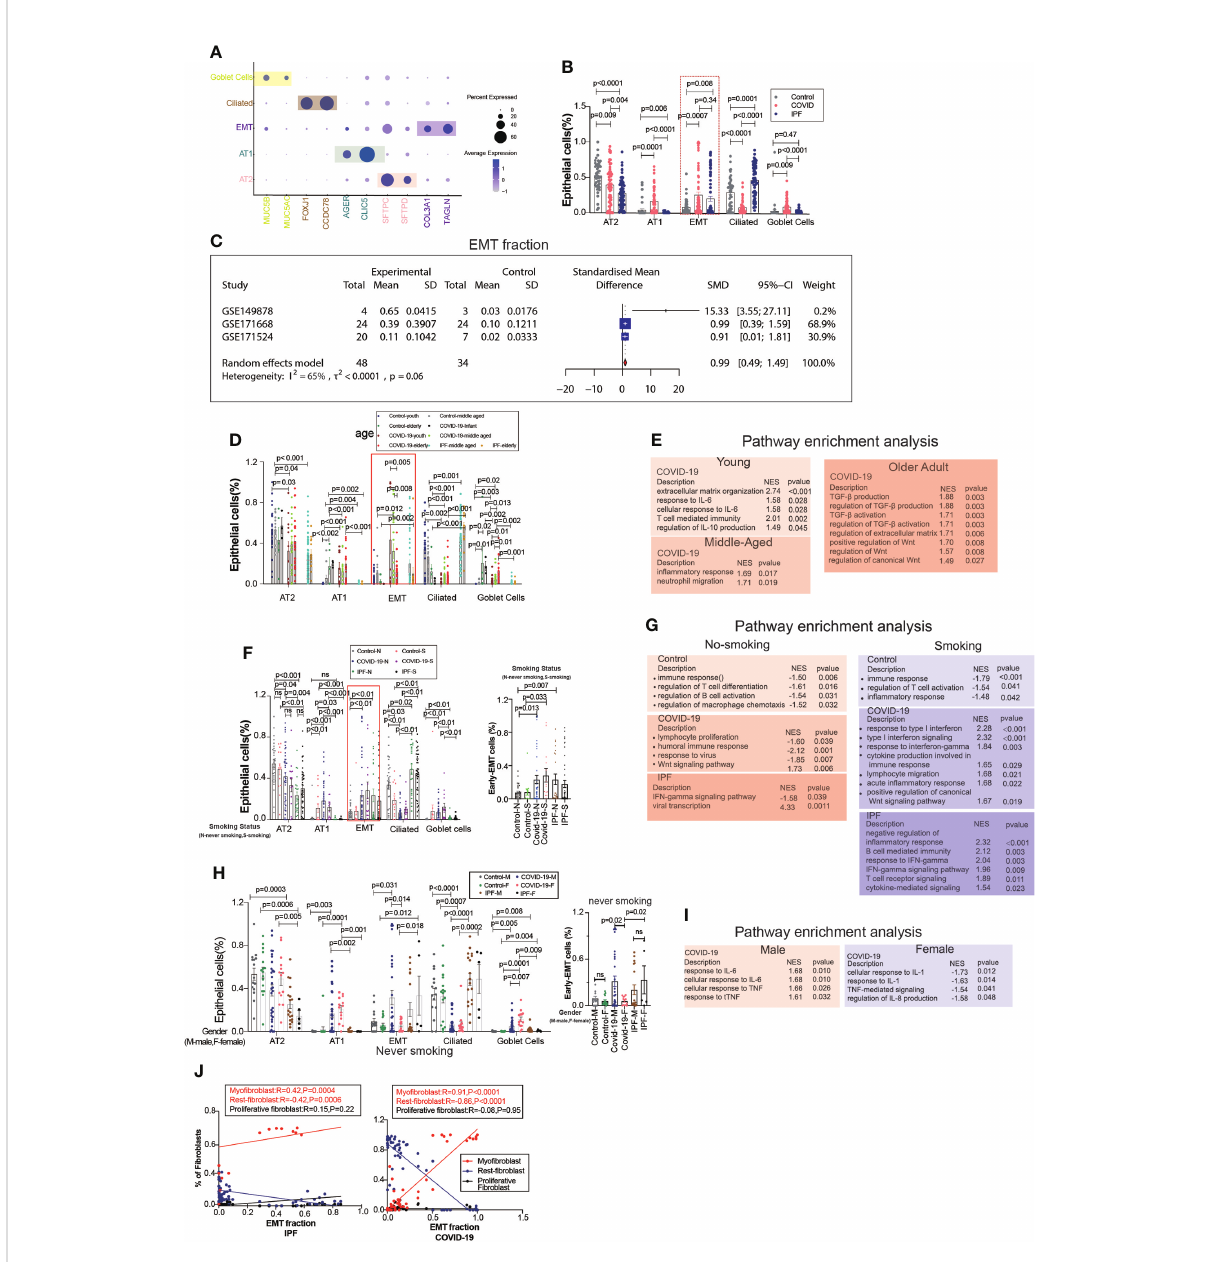
FIGURE 2 EMT by age, smoking status, and gender. (A) Dot chart shows the marker of epithelial subpopulations, including AT1(AGER, CLIC5), AT2(SFTPC, SFTPD), Ciliated (FOXJ1, CCDC78), Goblet cells (MUC5B, MUC5AC), EMT(TAGLN, COL3A1). (B) Comparison of the ratios of HC, COVID-19, IPF subpopulations of epithelium. EMT proportion was signi fi cantly upregulated in COVID-19 and IPF. (C) Forest plot of studies with EMT ratio on the COVID-19 and HC, after excluding a study with only one case and a high heterogeneity study. The analysis included data from 3 studies with a total of 48 COVID-19 and 34 controls. p value for heterogeneity was 0.06, I 2 was 65%. (SD, Standard deviation). (D) Comparison of the ratios of HC, COVID-19, IPF subpopulations of epithelium by age. (E) GO (Gene ontology) enrichment analysis was performed on the genes highly expressed in EMT in normal control, COVID-19 and IPF groups in patients of different ages, respectively, and the graphs show the signaling pathways enriched to EMT cell populations in different groups. (F) Comparison of the ratios of HC, COVID-19, IPF subpopulations of epithelium by smoking. (G) GO enrichment analysis was performed to enrich for genes that were highly expressed in EMT of smoking and non- smoking patients in normal control, COVID-19 and IPF groups, respectively, and the graphs show the signaling pathways enriched in EMT cell populations of different groups. (H) Comparison of the ratios of HC, COVID-19, IPF subpopulations of epithelium by sex. (I) GO enrichment analysis of the genes highly expressed in EMT in normal control, COVID-19 and IPF groups by sex, respectively. (J) Correlation analysis of EMT with myo fi broblast, rest fi broblast and proliferative fi broblast in COVID-19 and IPF patients (Pearson test), showing EMT is positively correlated with myo fi